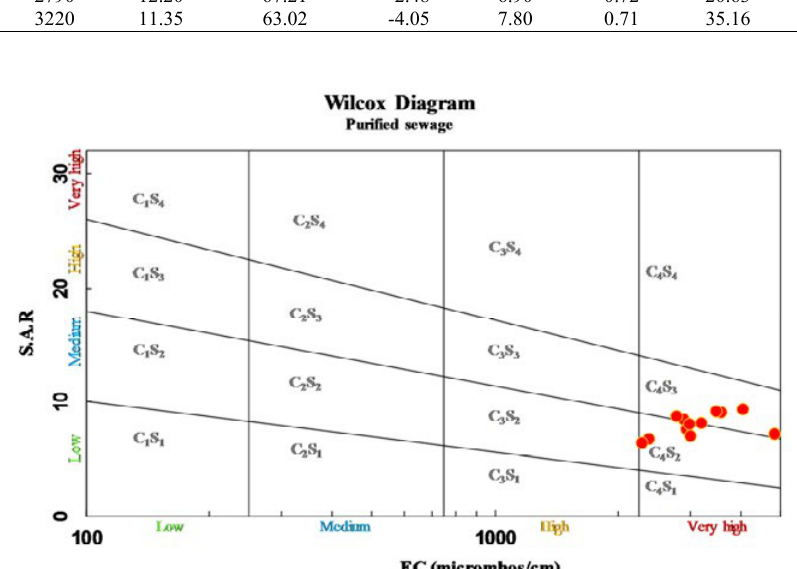
Fig. 5: Wilcox diagram of the samples collected from the TWW, showsing the medium to high sodium hazard and high and very high salinity hazards